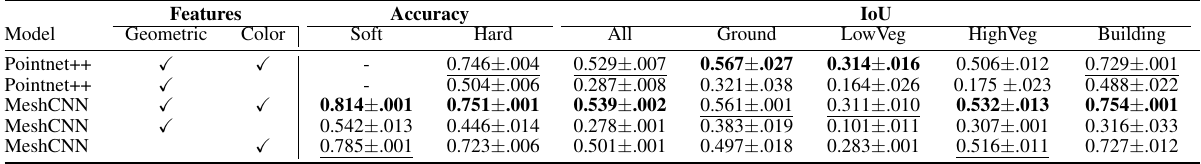
Table 3. Evaluation metrics for Pointnet++ and MeshCNN using either geometric features, photometric feature or both. The first and second best scoring methods are highlighted for each metric. Note inclusion of color features boosts performance significantly. a class occurs in the data set, the higher is its Jaccard